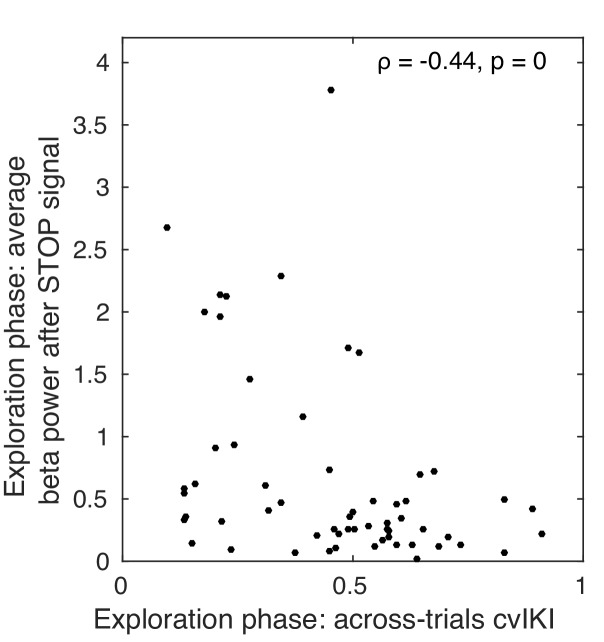
Correlation between average beta power and the degree of task-related behavioral variability across trials during the exploration phase.Non-parametric rank correlation in the total population (N = 60) between the mean beta power during the time interval following the STOP signal and cvIKI across trials. There was a significant negative correlation (Spearman ρ<-0.4397,P=0.0001), suggesting that an increased use of motor variability during exploration was associated with a reduction in beta power following trial performance.